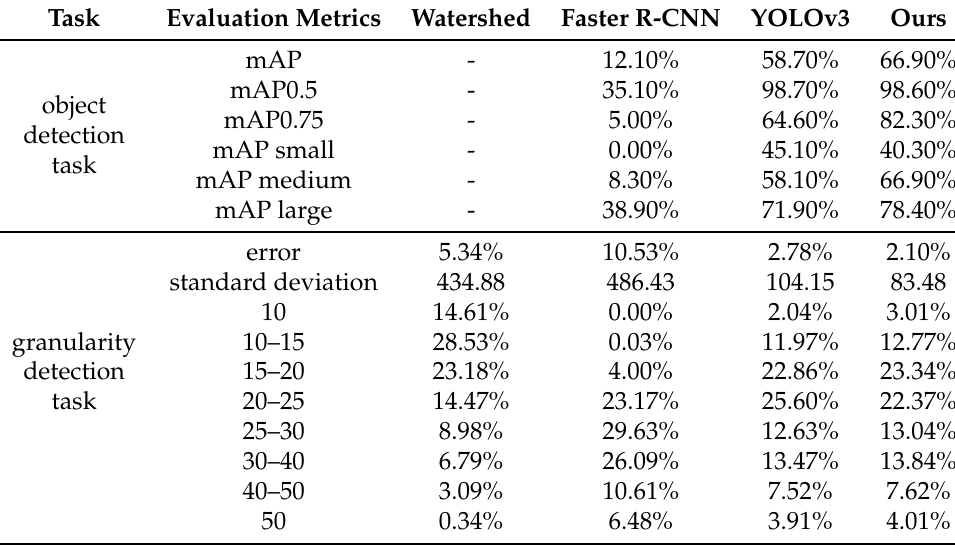
Table 4. Comparative experiments performed on the conglomerate validation set in